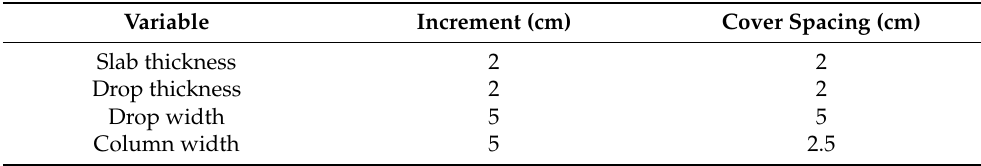
Table 5. Increments and cover spacings for decision